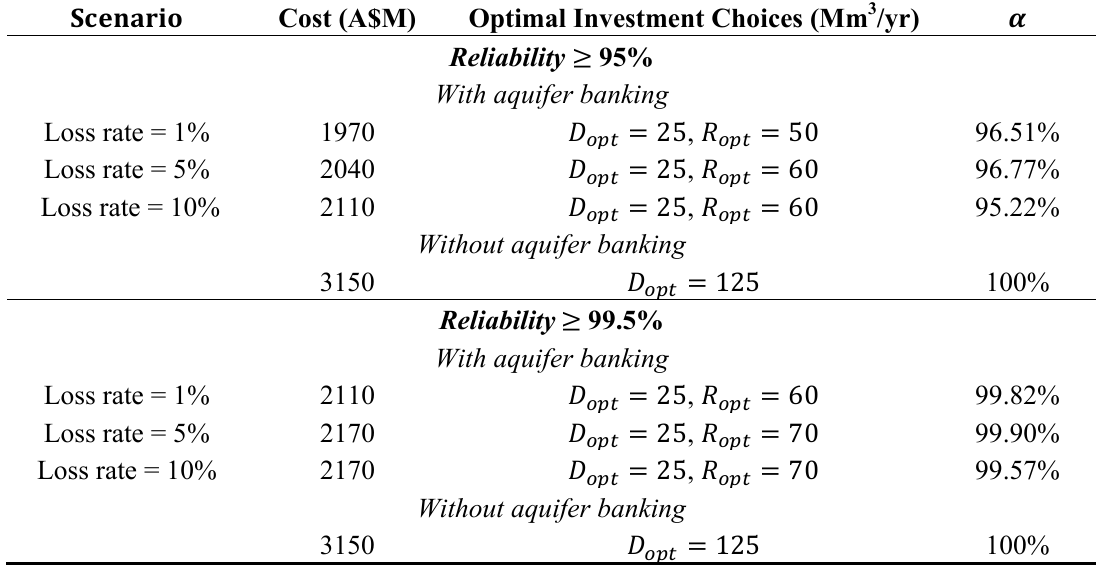
Table 1 . Minimum costs, optimal choices, and reliabilities under different model scenarios and reliability